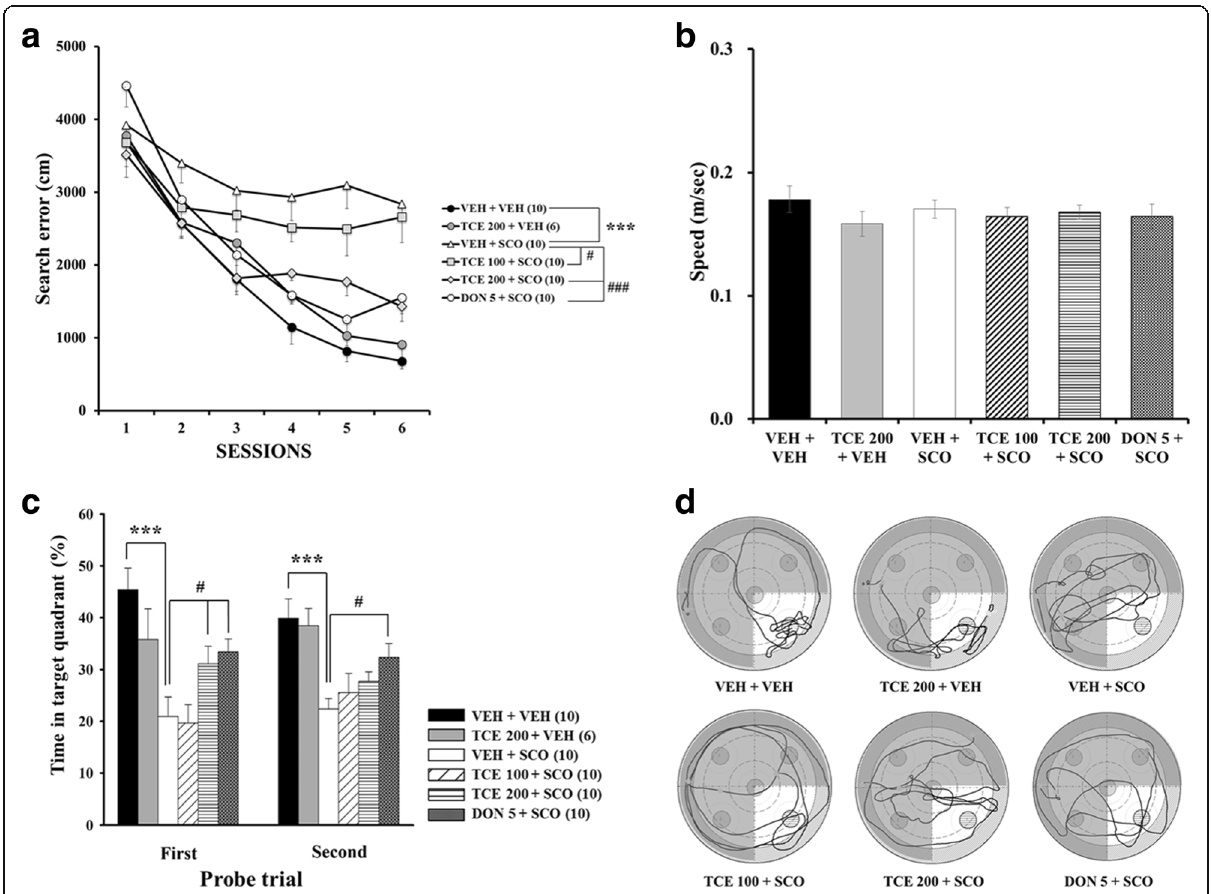
Fig. 2 Effect of TCE on scopolamine- induced memory impairment in the Morris water maze task . a Acquisition of spatial memory in mice. The cumulative search error (distance from the mice to escape platform) during 6 days of training is shown. The number in parentheses indicates the size per group ( n ). b Mean swimming speed of each group on the first day of training. c Retention of spatial memory in mice. Time spent in the target quadrant during the probe trial on day 11 (1st) and 13 (2nd) is shown. d Representative swimming tracks of mice in each group during the 1st probe test. The bright part indicates the target quadrant. The data are expressed as the means ± S.E.M. *** p < 0.001 compared with VEH + VEH; # p < 0.05, ### p < 0.001 compared with VEH + SCO. VEH; vehicle, SCO; scopolamine, DON;